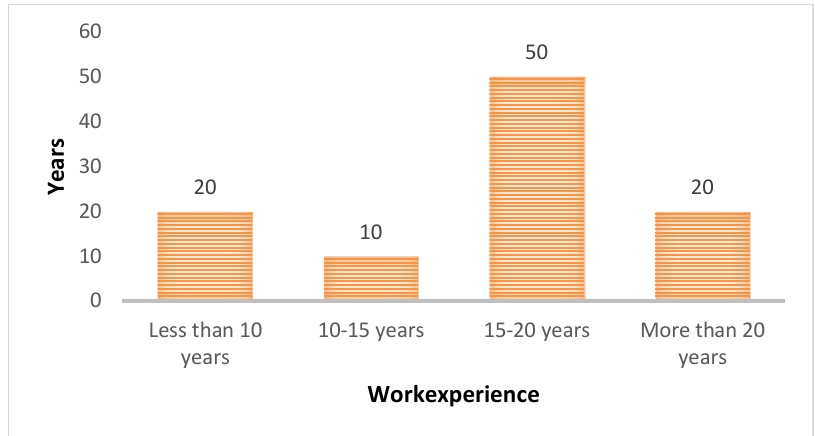
Fig. 4. Work experience of respondent experts.